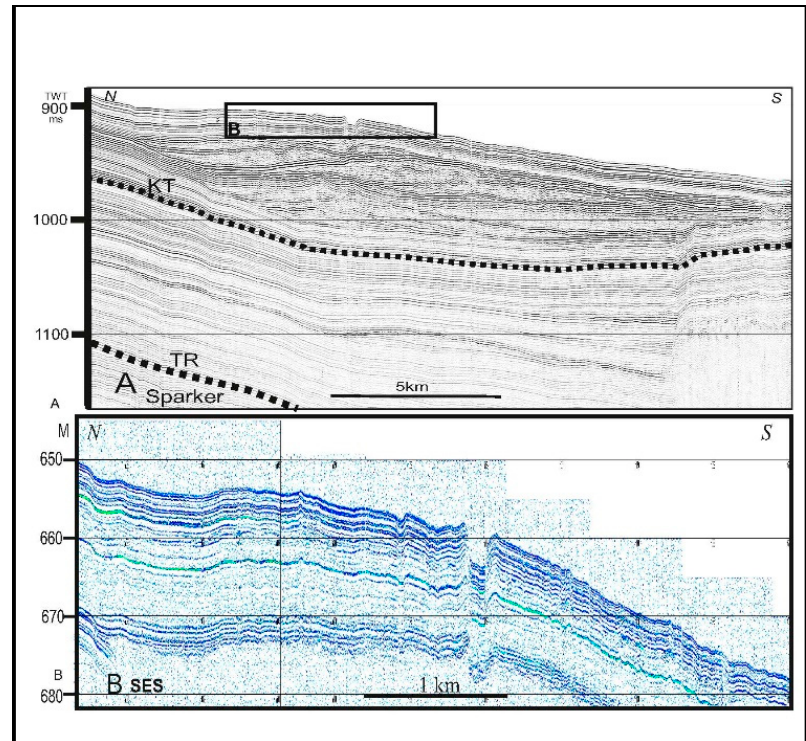
Figure 10. Sediment waves type 3 (contourite) on the northern slope of the Derbent Basin near the Mangyshlak Sill. ( A ) Fragment of the profile (sparker) NW-SE trending across foot of the slope. Main unconformities: TR—Turkanian regression, KT—Khvalinian transgression. ( B ) Enlarged fragment of ultra-high-resolution seismic reflection profile (SES) showing in detail uppermost sedimentary layer. Location of the profiles is shown in Figures 2 and 8.